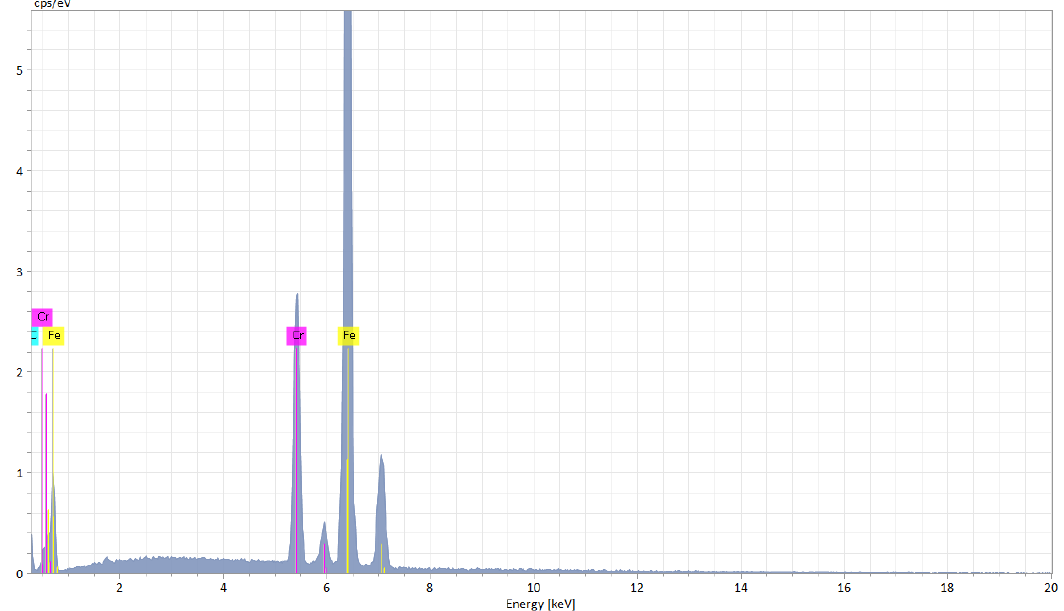
Figure 9. EDX spectrum of microtextured design octagonal donut shape (design type A).